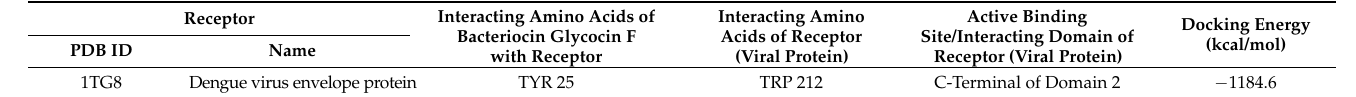
Table 6. Molecular docking analysis of bacteriocin glycocin F (PDB ID: 2KUY) derived from L. plantarum